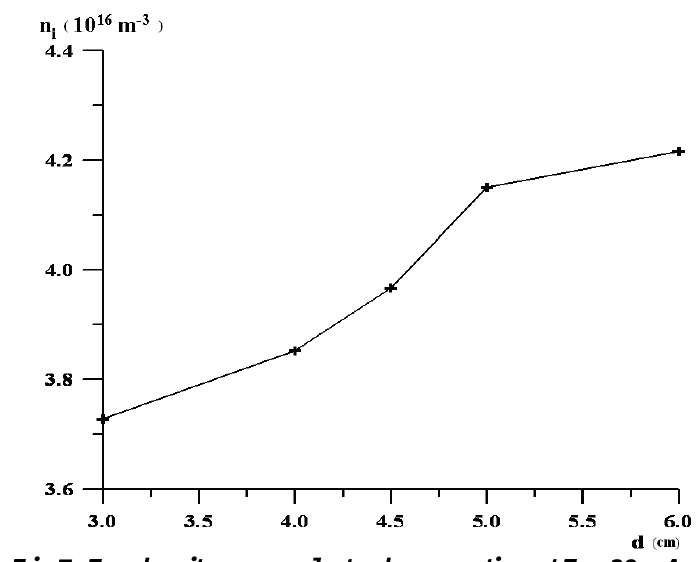
Fig.7: Ion density versus electrode separation at Id =30